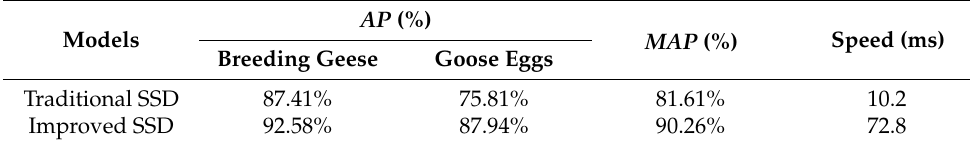
Table 2. Detection results of breeding geese and goose eggs.